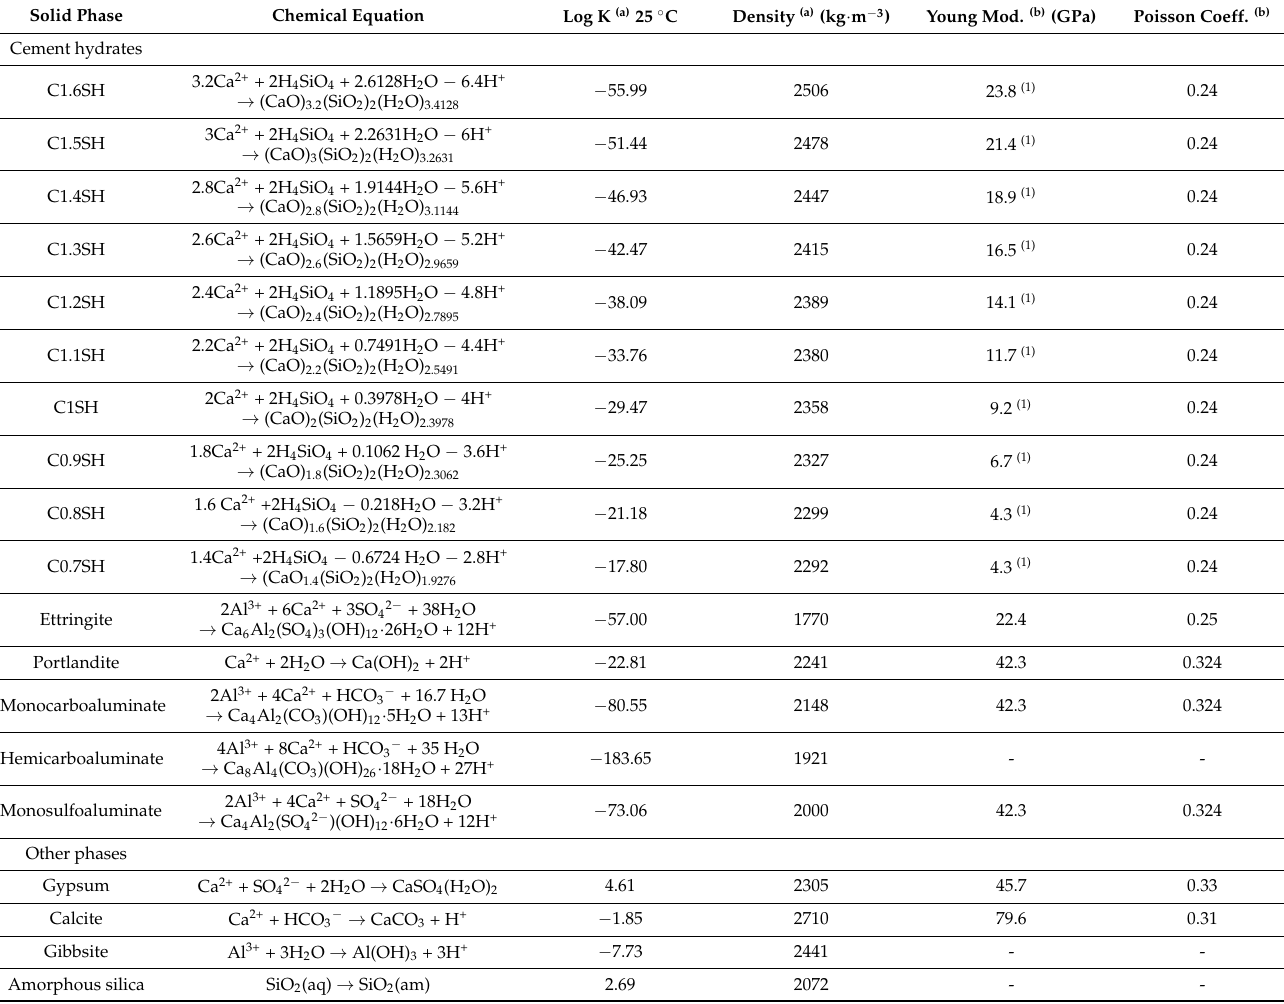
Table 2. Thermodynamic formation constants at chemical equilibrium and the mechanical properties of the solid phases considered in geochemical